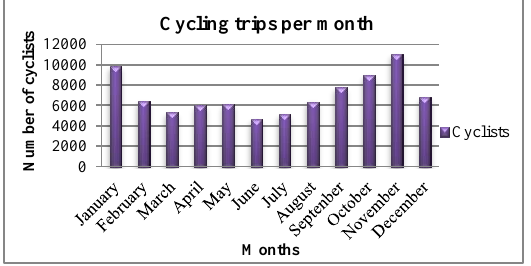
Figure 2: Cycling trips per month for year 2014